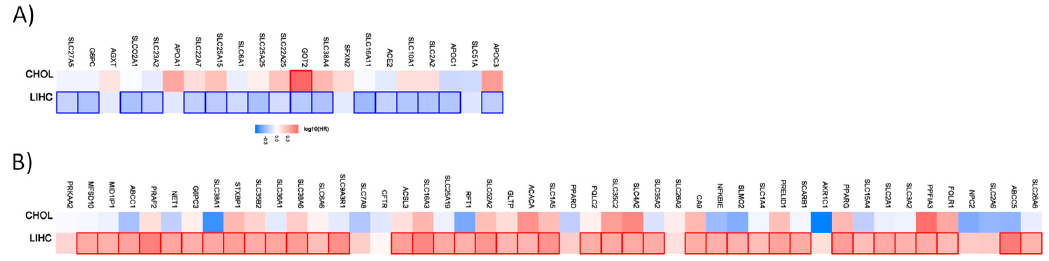
Figure 3. Hazard ratio of the organic anion transporter expression in different liver cancer subtypes. The hazard ratio (HR) was calculated for ( A ) the favorable and ( B ) unfavorable list of genes in liver cancer for cholangiocarcinoma (CHOL) and liver hepatocellular carcinoma (LIHC). The red and blue color denote higher and lower risk, respectively. The rectangles with frames represent the statistically significant HR ( p < 0.05).